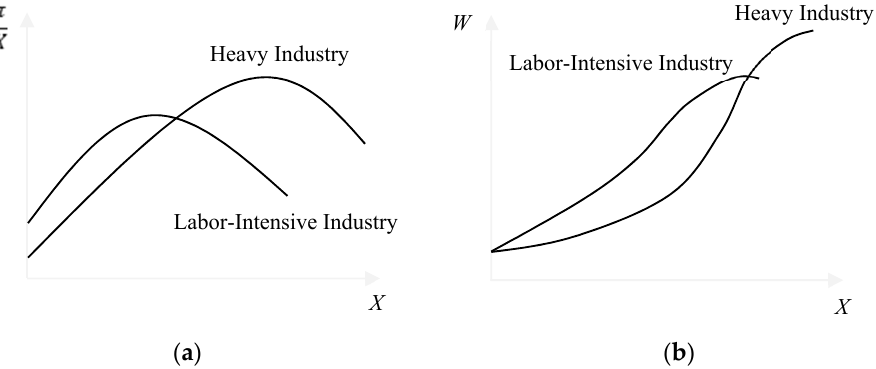
Figure 3. Productivity (in subfigure ( a )) and wealth accumulation (in subfigure ( b )) of heavy industry and labour ‐ intensive industry.